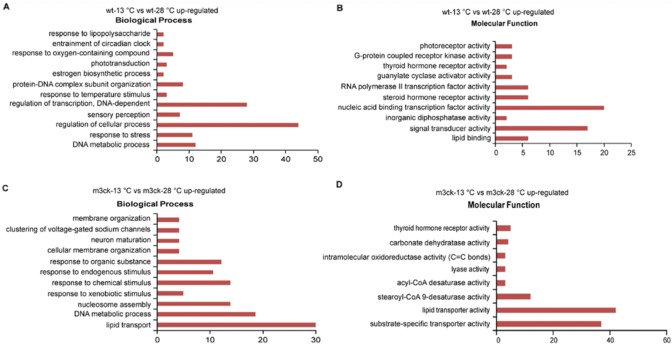
GO enrichment analysis of up-regulated transcripts in transgenic and wild-type fish under cold stress.A. Biological processes of wt-13°C vs. wt-28°C up-regulated genes. B. Molecular functions of wt-13°C vs. wt-28°C up-regulated genes. C. Biological processes of m3ck-13°C vs. m3ck-28°C up-regulated genes. D. Molecular functions of m3ck-13°C vs. m3ck-28°C up-regulated genes. The horizontal axis represents transcript count in each GO term. Up-regulated transcripts were submitted for GO enrichment analysis using the SAS online analysis system.